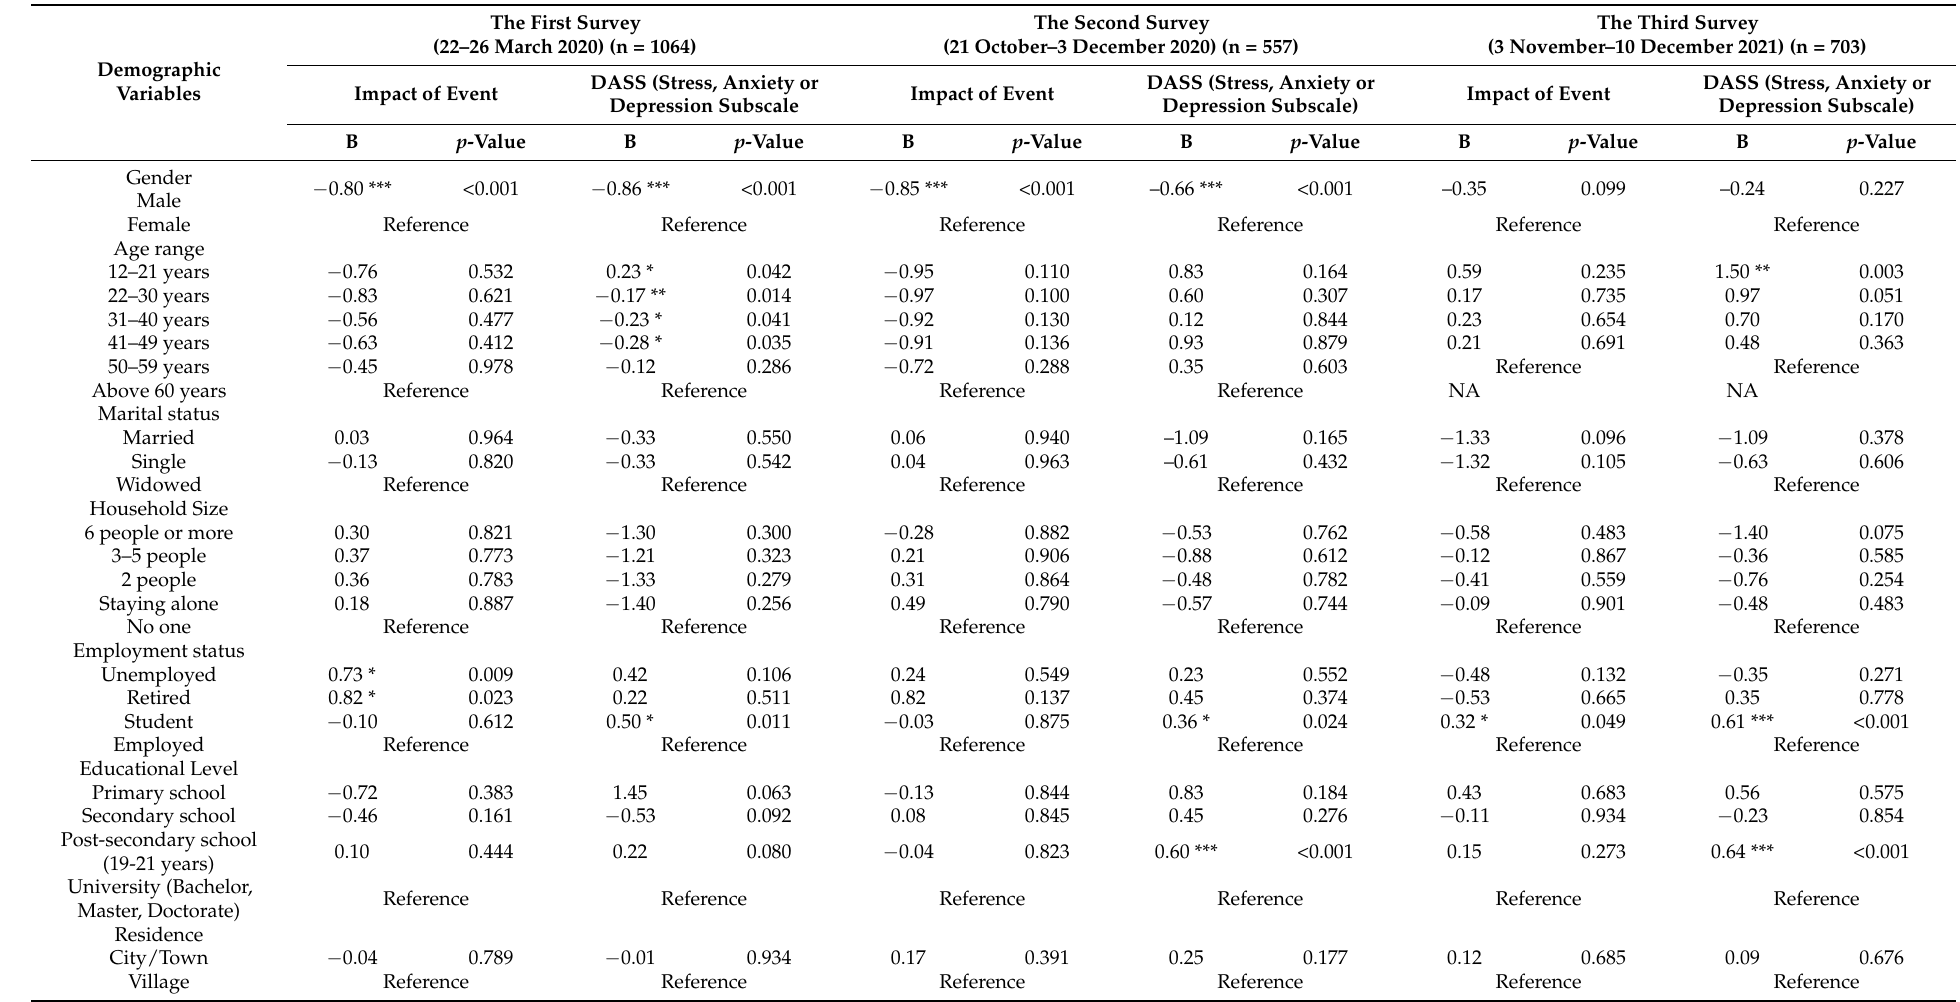
Table 1. Association between demographic variables and the psychological impact as well as adverse mental health status during the first, second and third surveys (n =